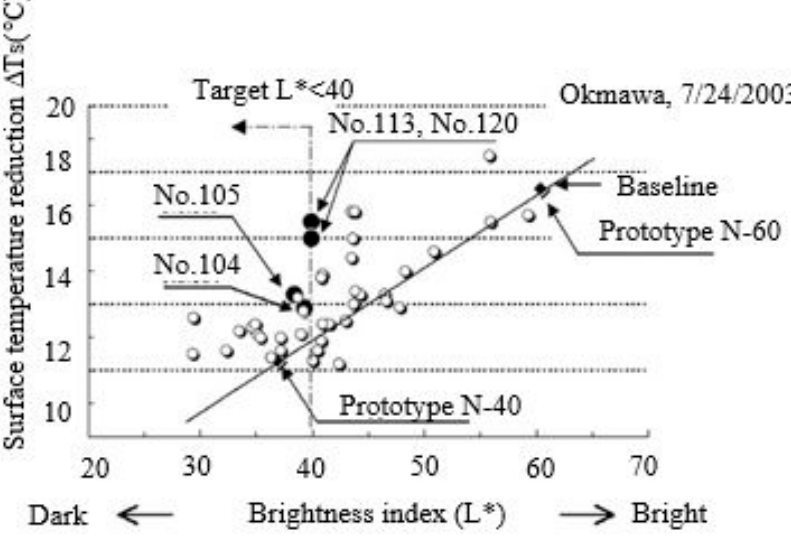
Figure 4. The relation between L* value and reduction of pavement surface temperatures (Black circles indicate high-quality coatings in terms of brightness and albedo) [114].